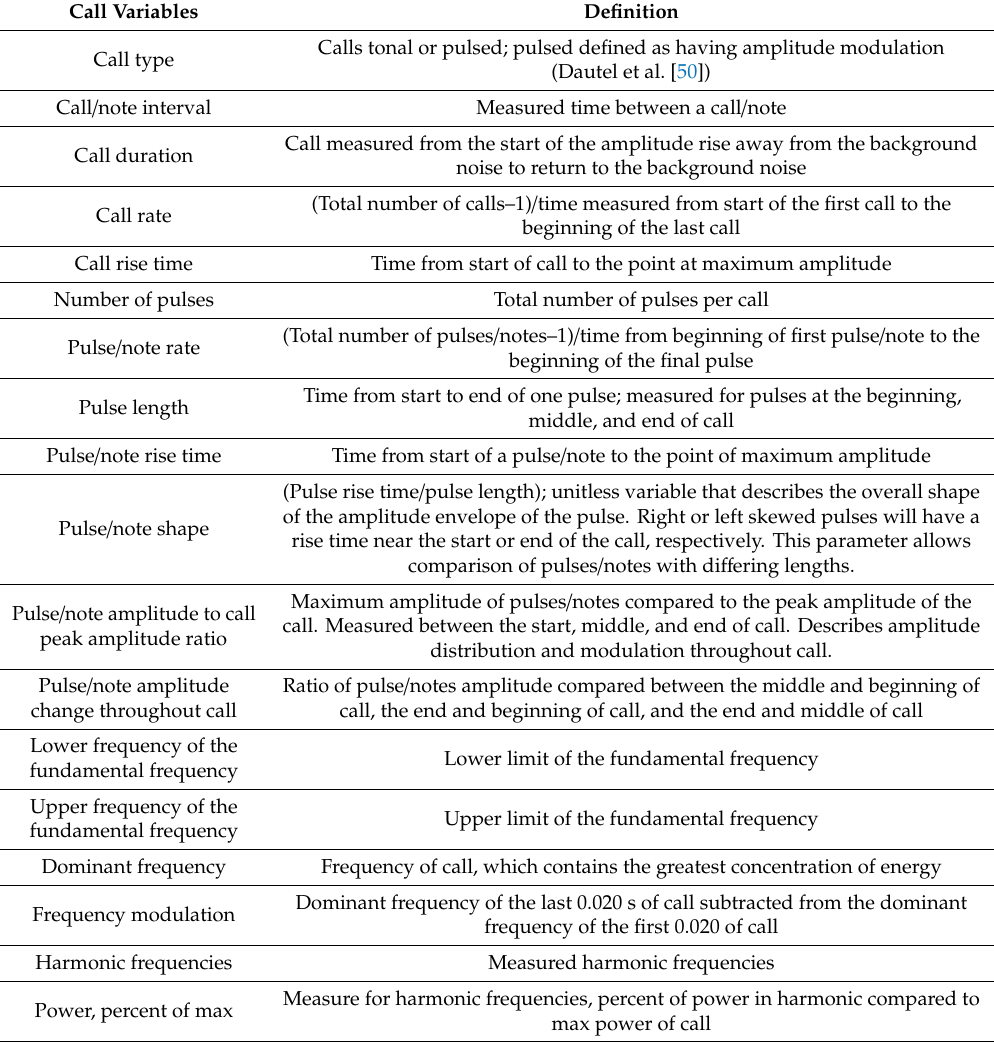
Table 1. Definitions of call variables